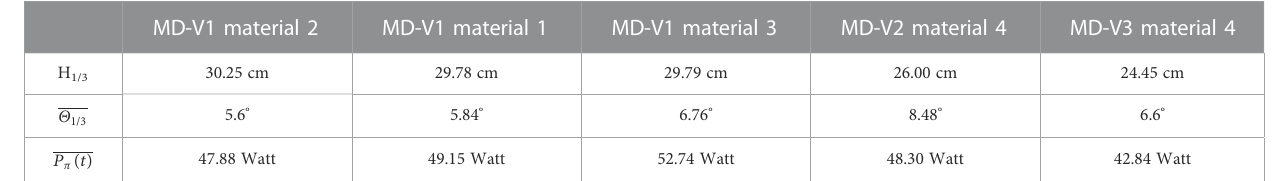
TABLE 1 Experimental results for different designs and